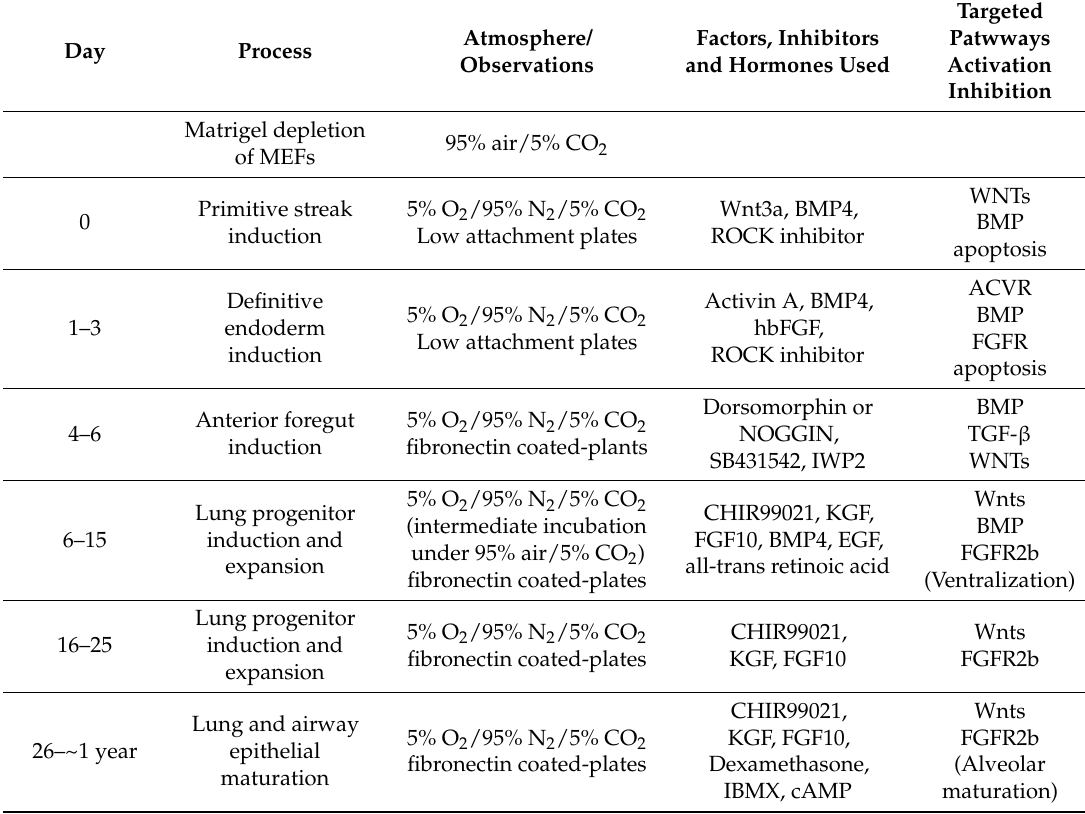
Table 1. Chronogram of the differentiation strategy followed to generate the two-dimensional minilung from hESCs (human embryonic stem cells). Day Process